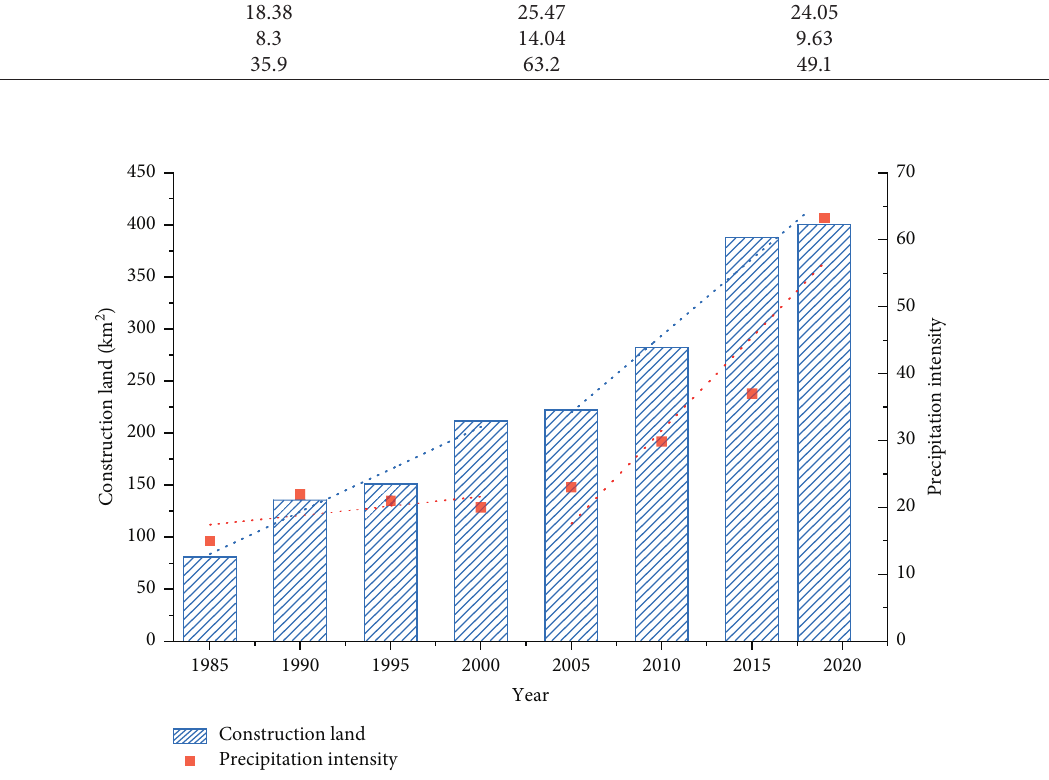
Figure 13: Construction land and precipitation intensity trend in the study area.